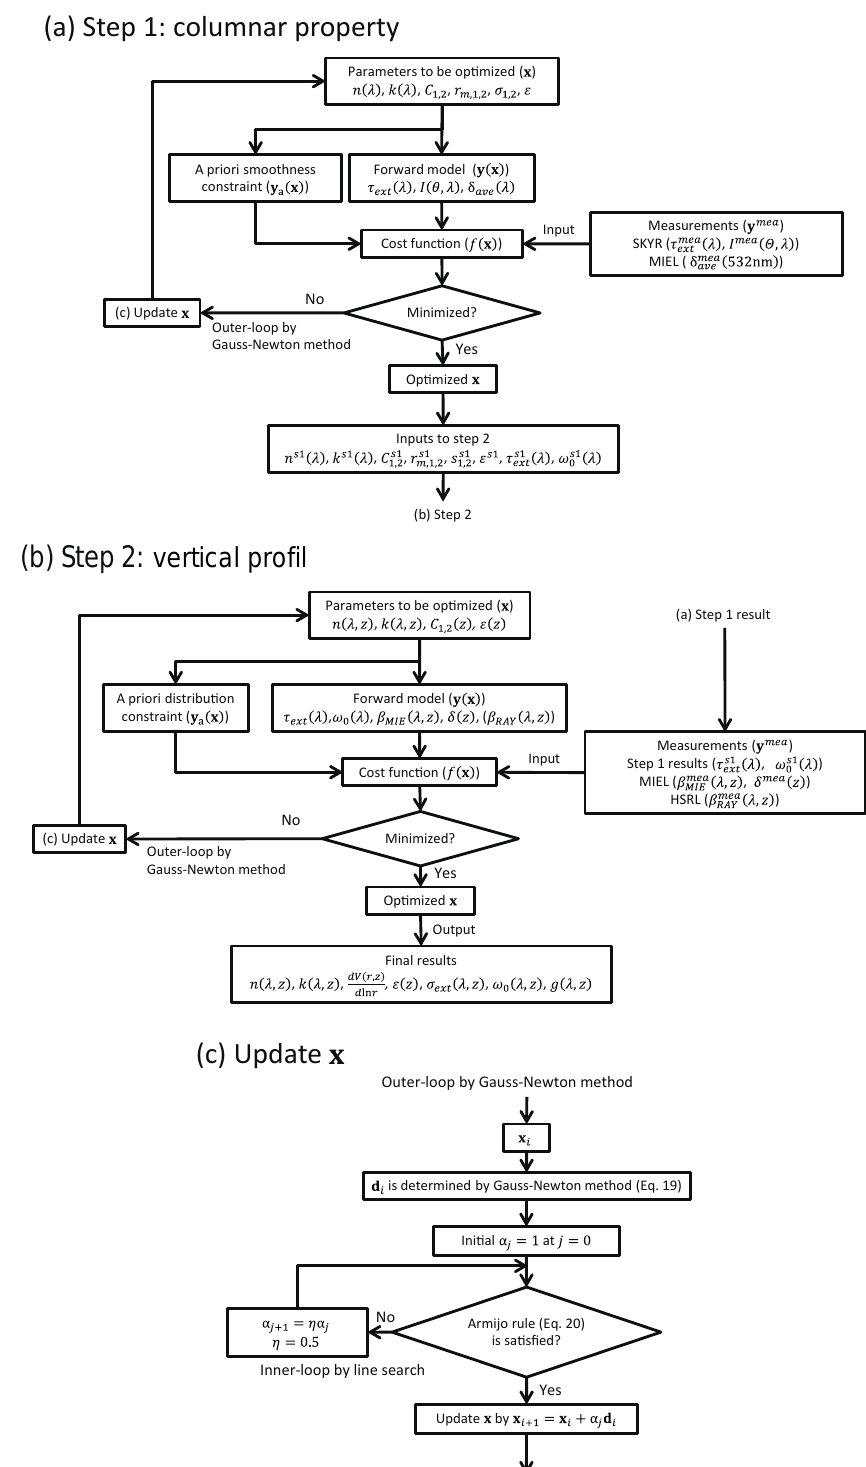
Figure 1. Schematic diagrams of the retrieval procedures: (a) step 1, (b) step 2, and (c) updating parameters x